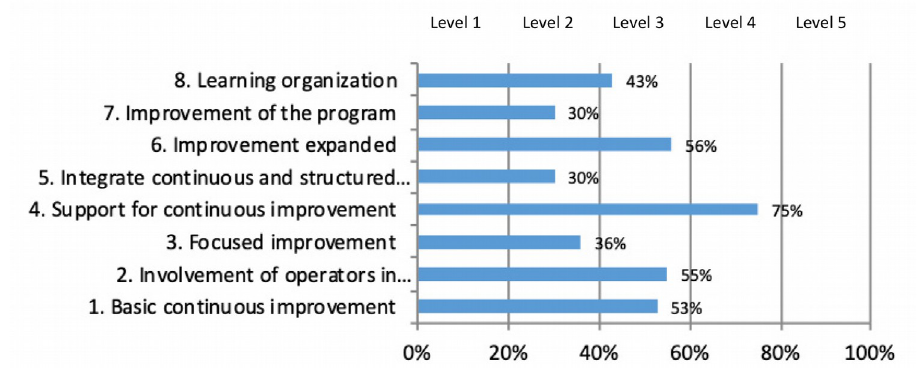
Figure 5. Maturity level in C3